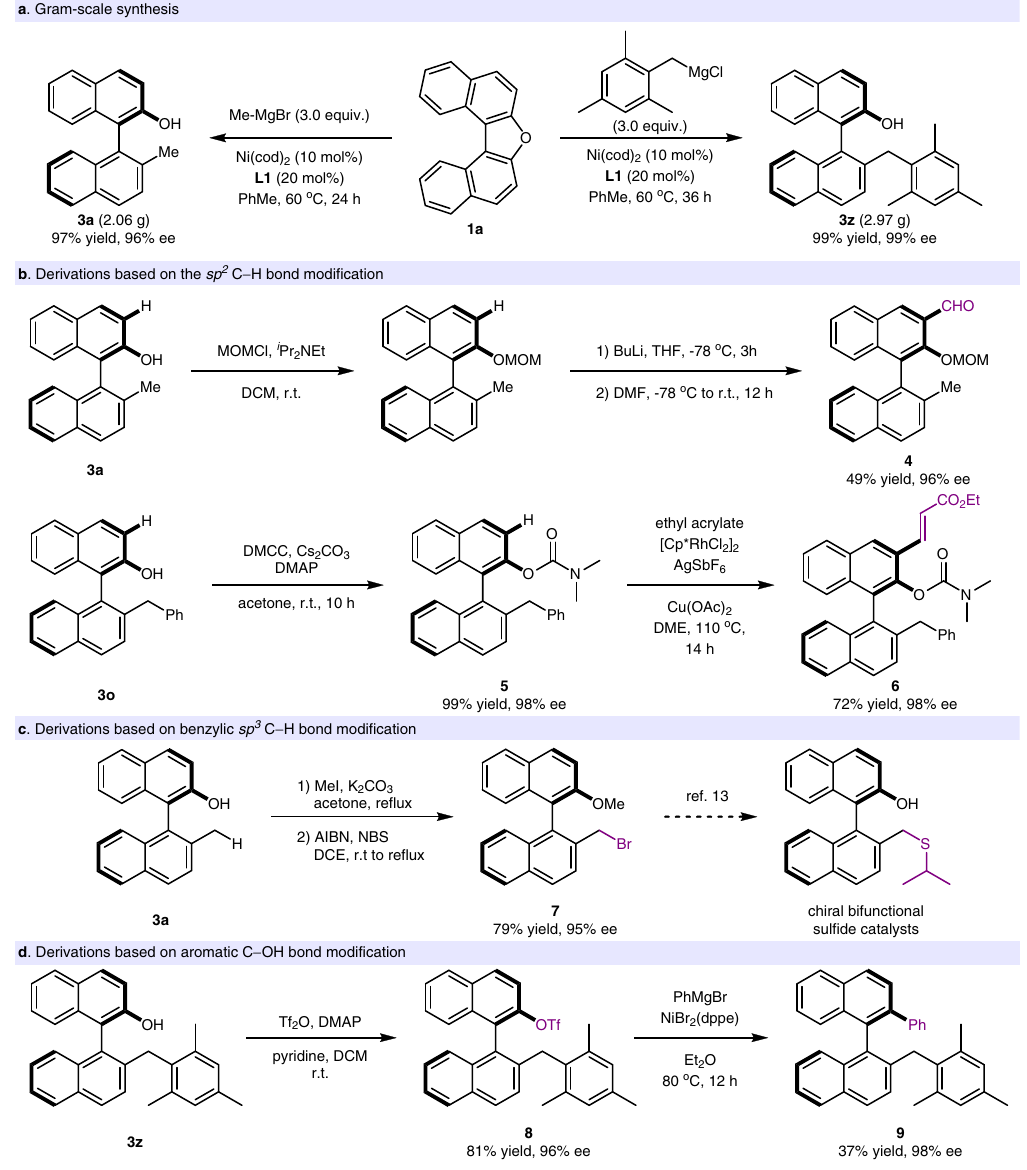
Fig. 4 Gram-scale synthesis and derivation experiments. a Gram scale synthesis. b Derivations based on the sp 2 C – H bond modi fi cation. c Derivations based on benzylic sp 3 C – Hbondmodi fi cation. d DerivationsbasedonaromaticC – OHbondmodi fi cation.MOMClchloromethylmethylether,DMFdimethylformamide,DMCC dimethylcarbamyl chloride, DMAP 4-dimethylaminopyridine, AIBN azobisisobutyronitrile, NBS N-bromosuccinimide, dppe